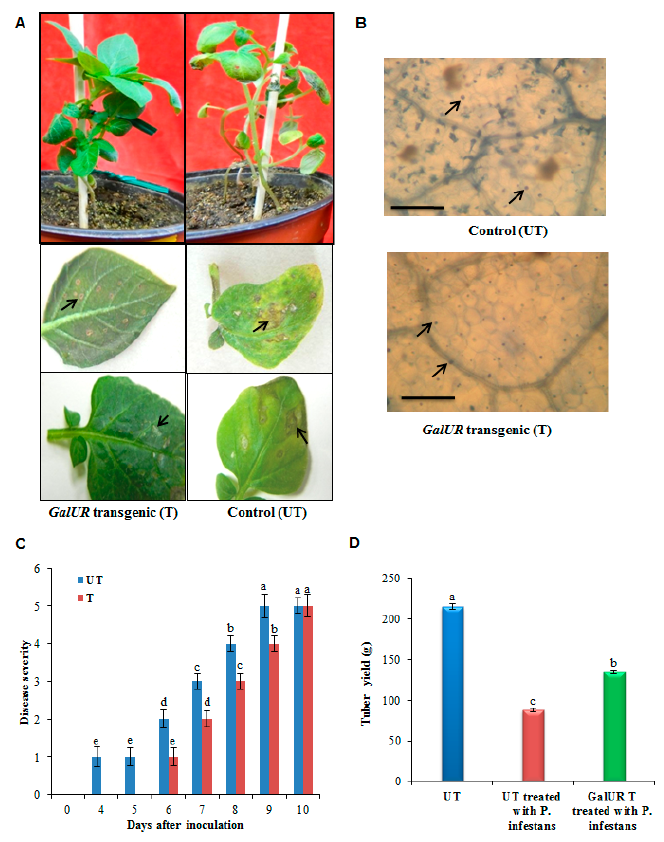
Figure 1. Pathogen infection in control and GalUR potato challenged with P. infestans. ( A ) GalUR transgenic potato plants showing restricted lesions and necrosis development (arrows) compared to control plants, ( B ) Microscopic appearances of P. infestans infected potato leaves stained with lactophenol-Trypan blue. The numbers of dead cells were seen in control plants while few dead cells were present in the GalUR potato transgenics after P. infestans infection. Bars = 200 µ m, ( C ) Disease severity in potato plants. Disease range of damage caused by P. infestans after inoculation of leaves of potato plants. The disease severity index (DSI) scoring values (0–5) for the estimation of disease severity were assigned as follows: 0—no visible symptoms or lesions, 1 —scarce visible lesions, 2—small lesions with 1% discoloration of leaves, 3—discoloration of leaves up to 10% with increased lesion size, 4—increased leaf discoloration (25%), 5—increased leaf discoloration ( > 25%), and severe damage. Each bar represents a means ± standard deviation of n = 6. Di ff erent letters indicate a significant di ff erence in disease severity according to a Kruskal–Wallis non-parametric test at p = 0.002, ( D ) Tubers yield in the untransformed (UT) control and GalUR transgenic potato challenged with P. infestans and UT control plants and the data are presented as means ± SD of three replicates. Di ff erent letters indicate a significant di ff erence at p ≤ 0.05.